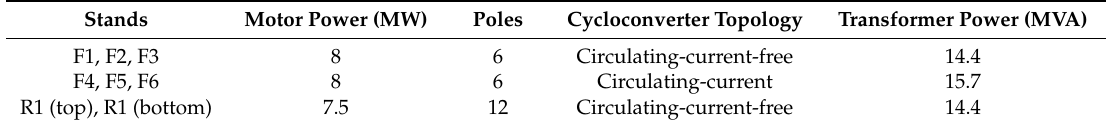
Figure 1. Schematic of the hot rolling mill. Table 1. Main characteristics of the stands.